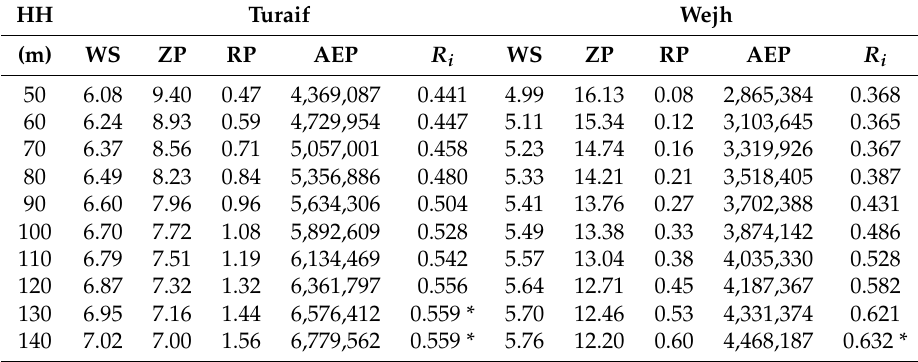
Table A5. TOPSIS analysis for turbine Doosan WinDS3000. The best choice for each site is marked with an asterisk. HH Turaif Wejh